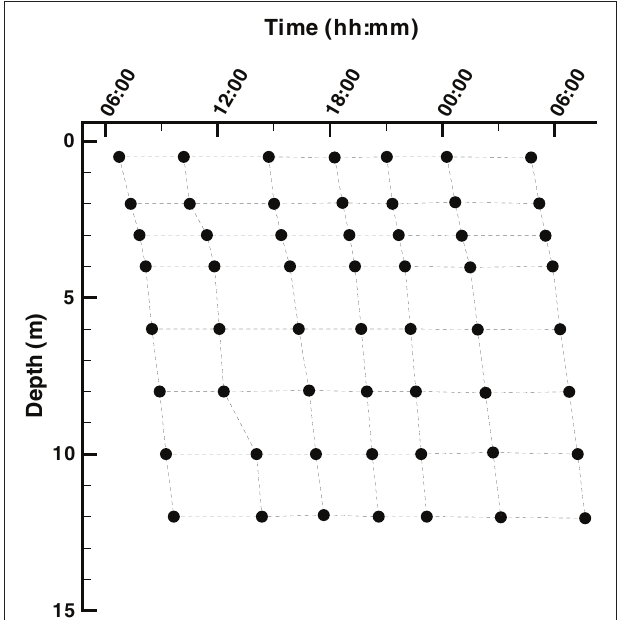
FIGURE 2 | Layout of the Siders Pond 2D ( t , z ) sample grid. Samples were collected over a 24h diel cycle starting at ∼ 6:00 on 25 Jun 2015 and ending at ∼ 6:00 on 26 Jun 2015. Samples were collected at 0.5, 2, 3, 4, 6, 8, 10, and